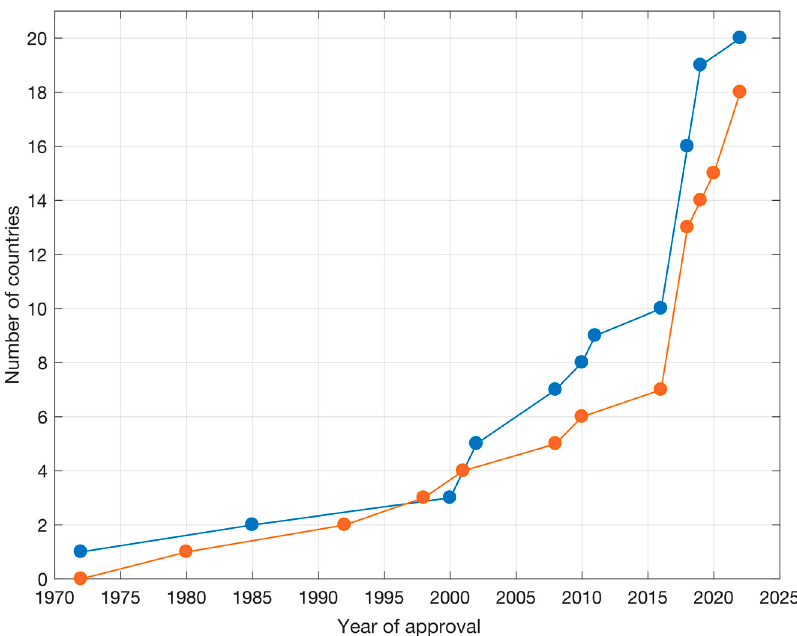
Figure 2. Number of countries vs. year of approval of regulation on radon protection in: workplaces (blue); dwellings and other indoor environments (existing or newly built) (orange).